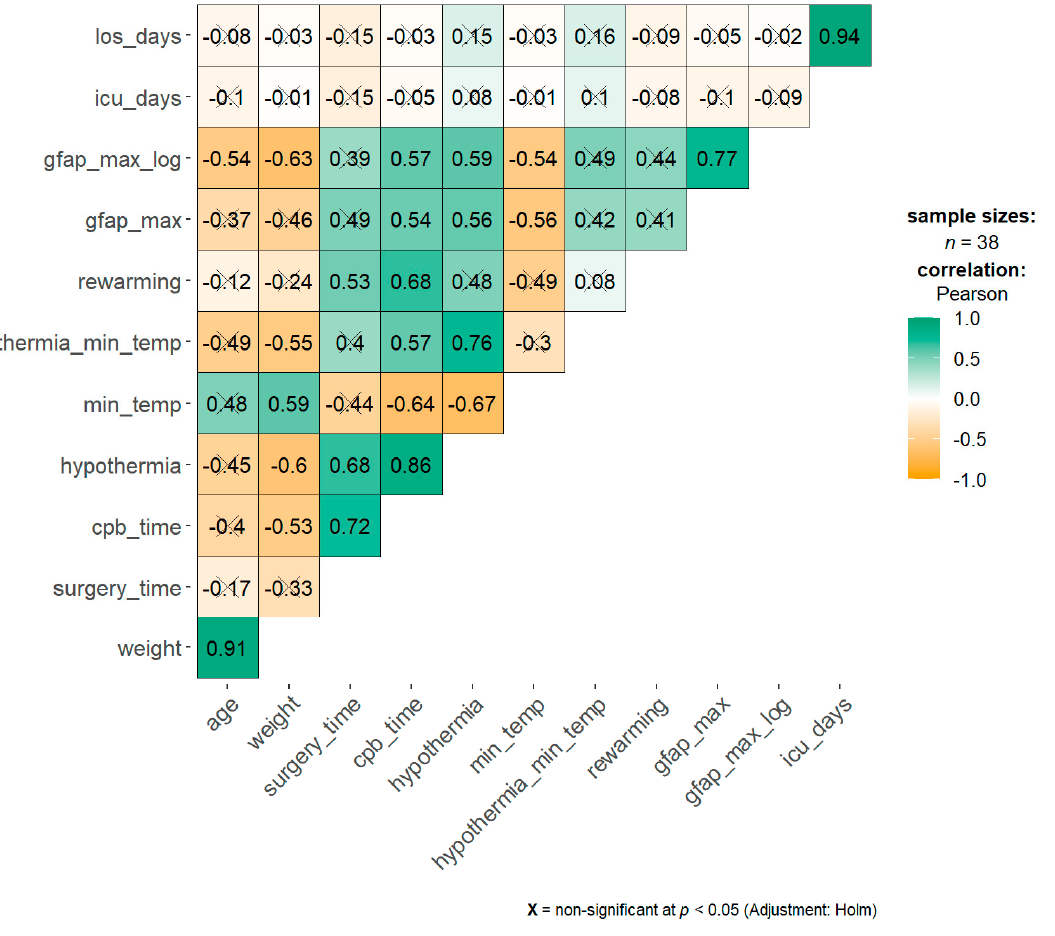
Figure 2. Correlation matrix among surgery parameters and GFAP max value. Spearman’s Rho value is reported inside each square. Color intensity is related to the Rho coefficient: orange as negative correlation, green as positive. Crossed Rho values are non-significant. p -values were adjusted for multiple comparisons. los : length of stay, icu : intensive care unit, cpb : cardiopulmonary